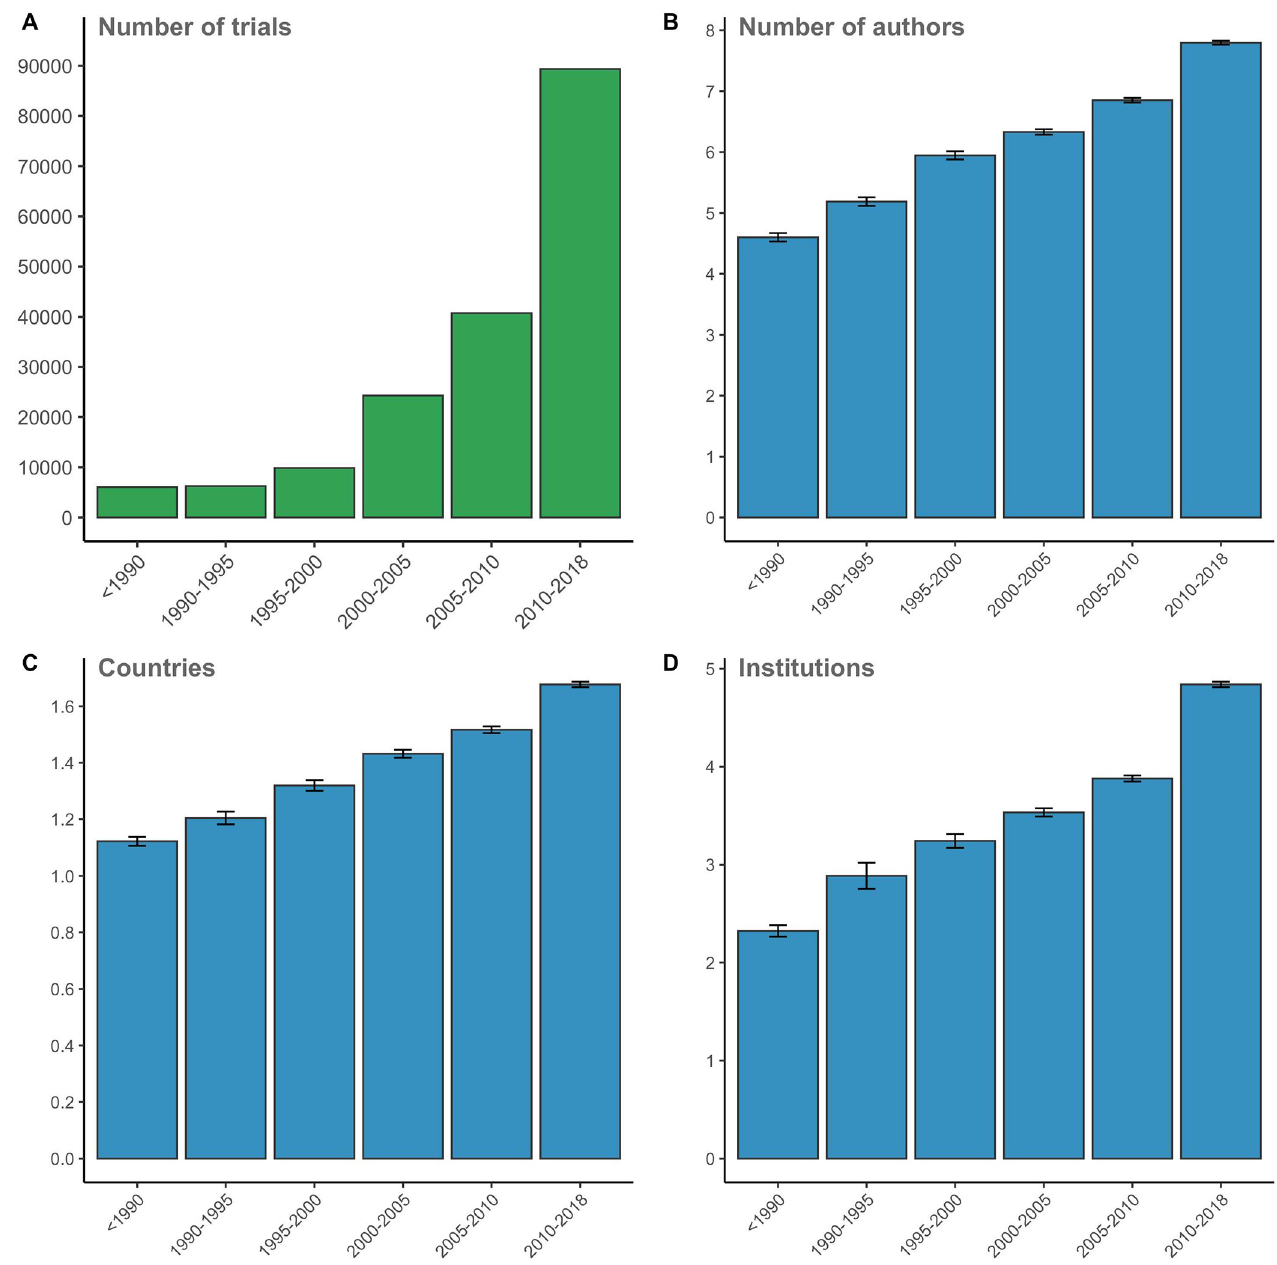
Fig 2. Number of RCTs included over time (A) and the corresponding average number of authors (B) , the number of countries involved (C) , and the number of institutions involved (D) . The indicated stratum range is up to but not including the last year. Raw data are available via DOI 10.5281/zenodo.4362238. RCT, randomized controlled